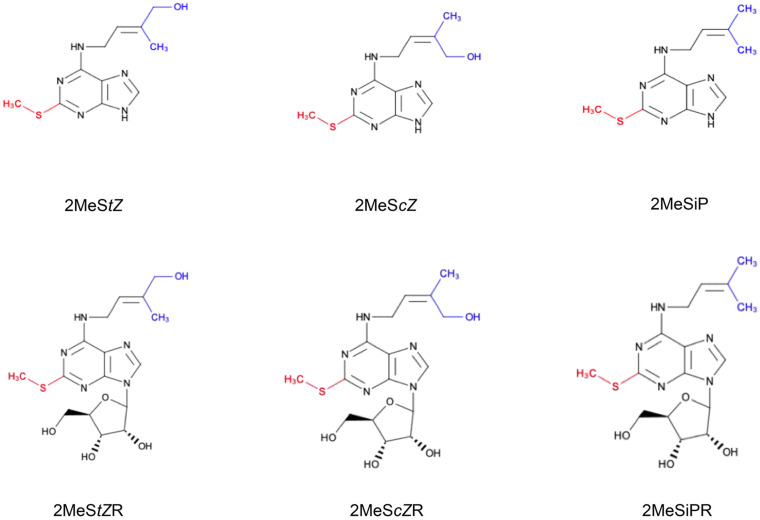
Chemical structures of methylthiolated cytokinins (2MeS-CKs). The attachment of the –S–CH3 group (red) at C2 position of the adenine ring of tRNA-bound CKs is regulated by methylthiotransferase-like enzymes. 2MeS-CK forms differ based on the modifications to their isoprenoid side chain (blue) and include: 2-methylthio-transZeatin (2MeStZ), 2-methylthio-cisZeatin (2MeScZ), and 2-methylthio-isopentenyladenine (2MeSiP), and their riboside derivatives: 2MeStZR, 2MeScZR and 2MeSiPR, respectively.